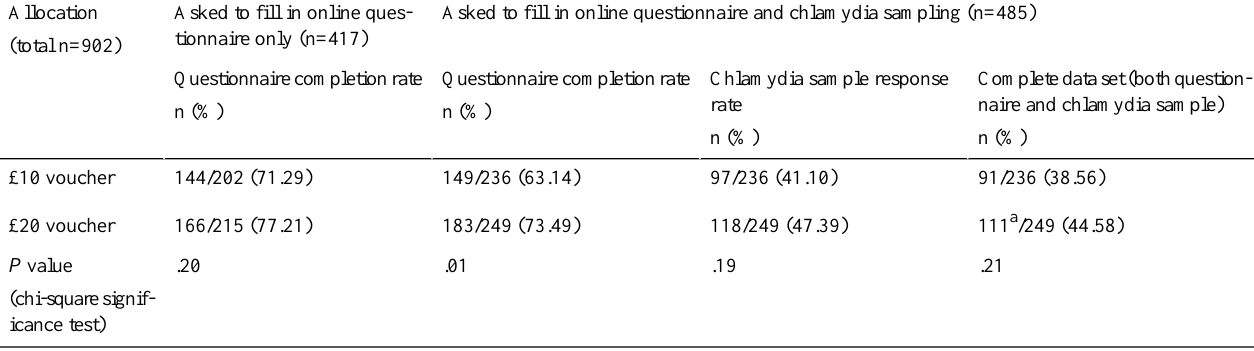
Table 5. Response rates at 3-month follow-up by level of compensation offered and chlamydia sample request. Asked to fill in online questionnaire and chlamydia sampling (n=485)Asked to fill in online